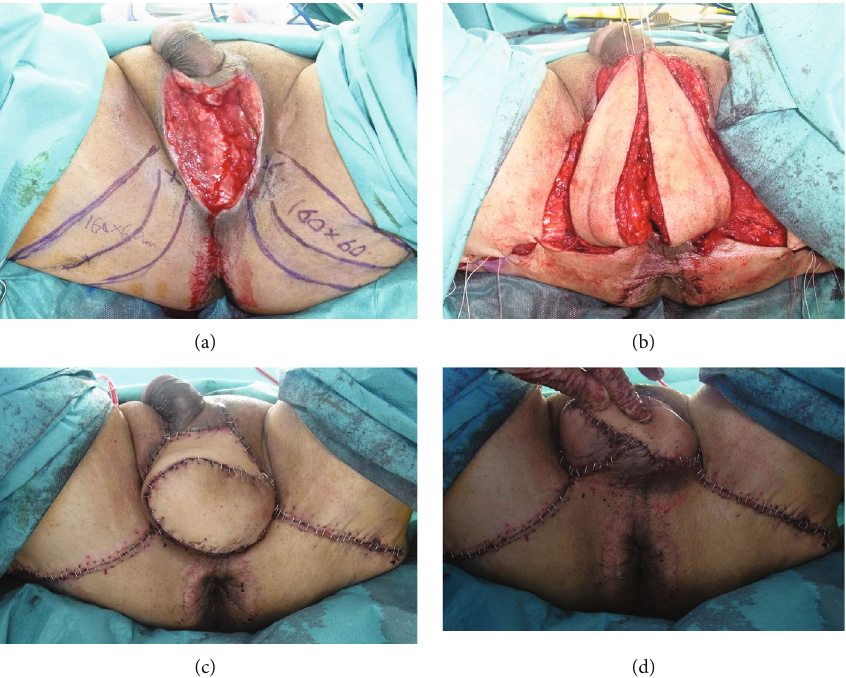
Figure 2: Case 1, reconstruction of a scrotum. (a) Skin fl ap design. X indicates a perforator. (b) Skin fl aps were elevated. (c) Immediately postsurgery anterior view of the scrotum. (d) Immediately postsurgery posterior view of the